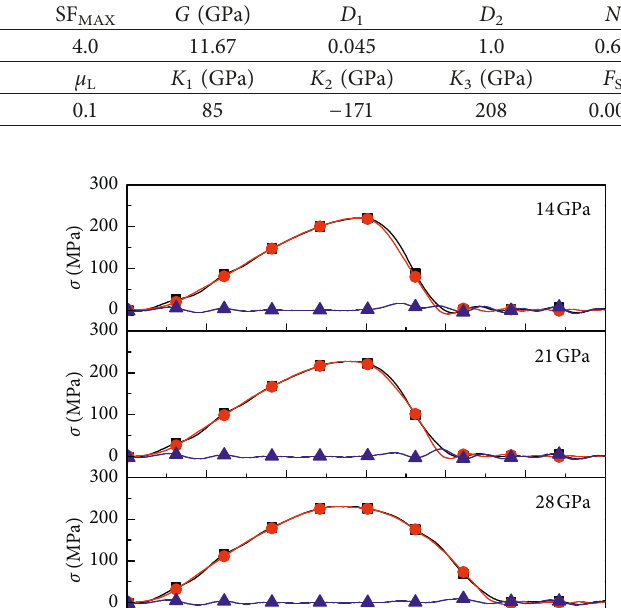
Figure 2: Acquired incident, reflected, and transmitted stresses when Young’s modulus is 28GPa.